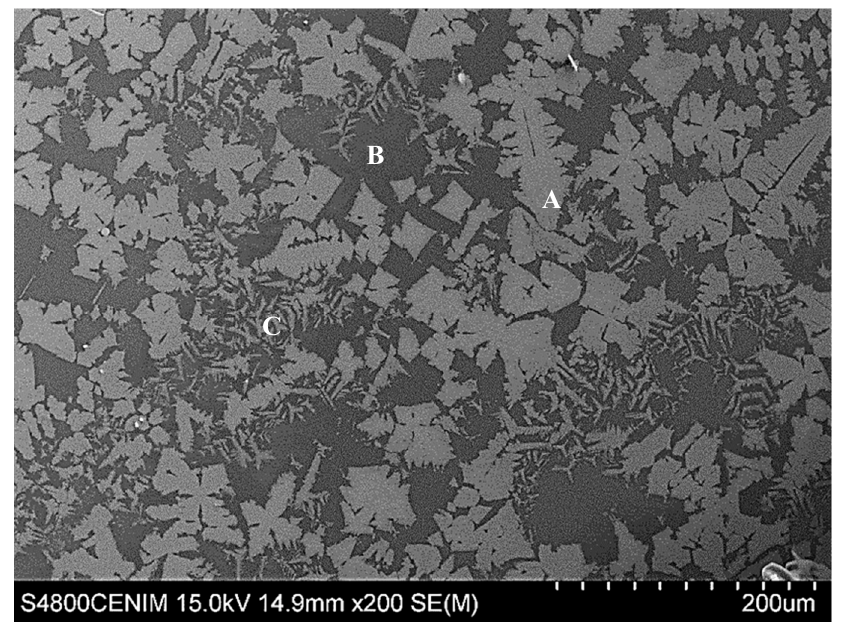
Figure 8. SEM (Scanning Electronic Microscopy) image of the slag ( A ) 40.7% Ta 2 O 5 ; 20.3% Nb 2 O 5 ; 16.7% CaO; ( B ) 4.5% Ta 2 O 5 ; 21.5% Nb 2 O 5 ; 20.5% CaO; 12.5% MnO; ( C ) Ca(Fe,Mn) 2 O 2 .